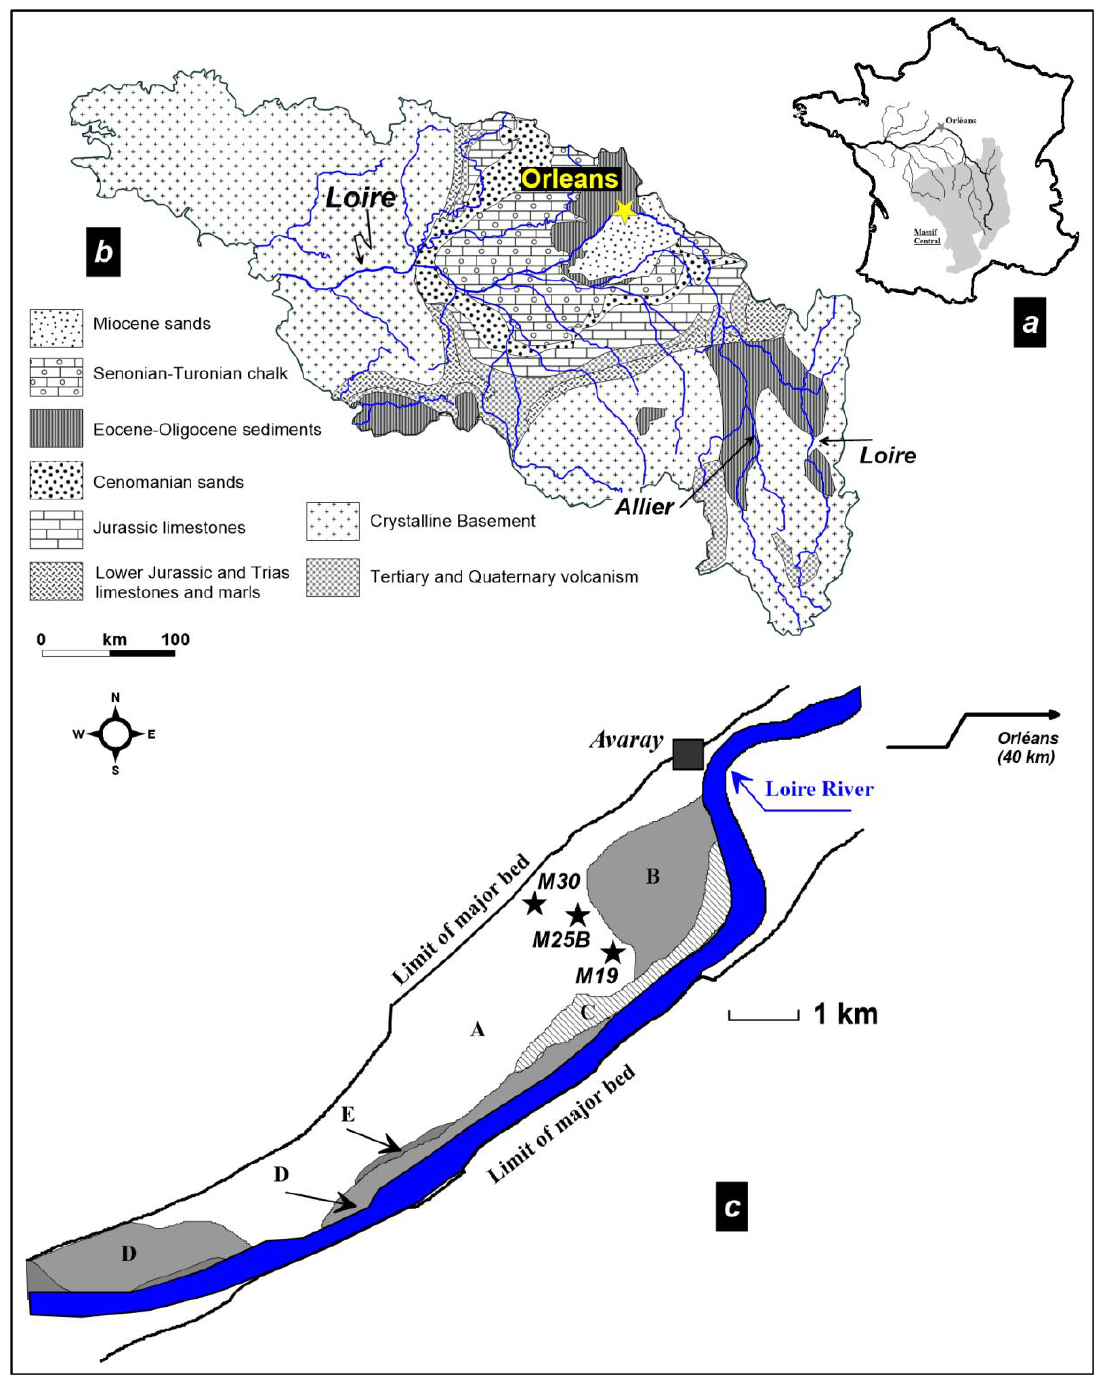
Figure 1. ( a ) Location of the Loire River catchment in France. ( b ) Simplified geological map of the upper Loire river catchment (modified from Négrel et al. [9]); ( c ) map of the Val d’Avaray meander. The sites where the cores were extracted are indicated, the meander structure and distribution of sediment bodies A–E (modified from Garcin et al. [12]) are also shown. The bodies were identified on the basis of aerial photographs, lithological data, thickness and altitude of the Aquitanian limestone substratum provided by more than 200 boreholes in the area. Each body corresponds to a slight migration of the main river channel. Stage A is the oldest, corresponding to migration of a meander with frontal erosion and prograding sand bars, and was eroded by stage B. Bodies C and D have a slightly sinuous to rectilinear path and body E shows well-preserved sand-filled channels and islands.